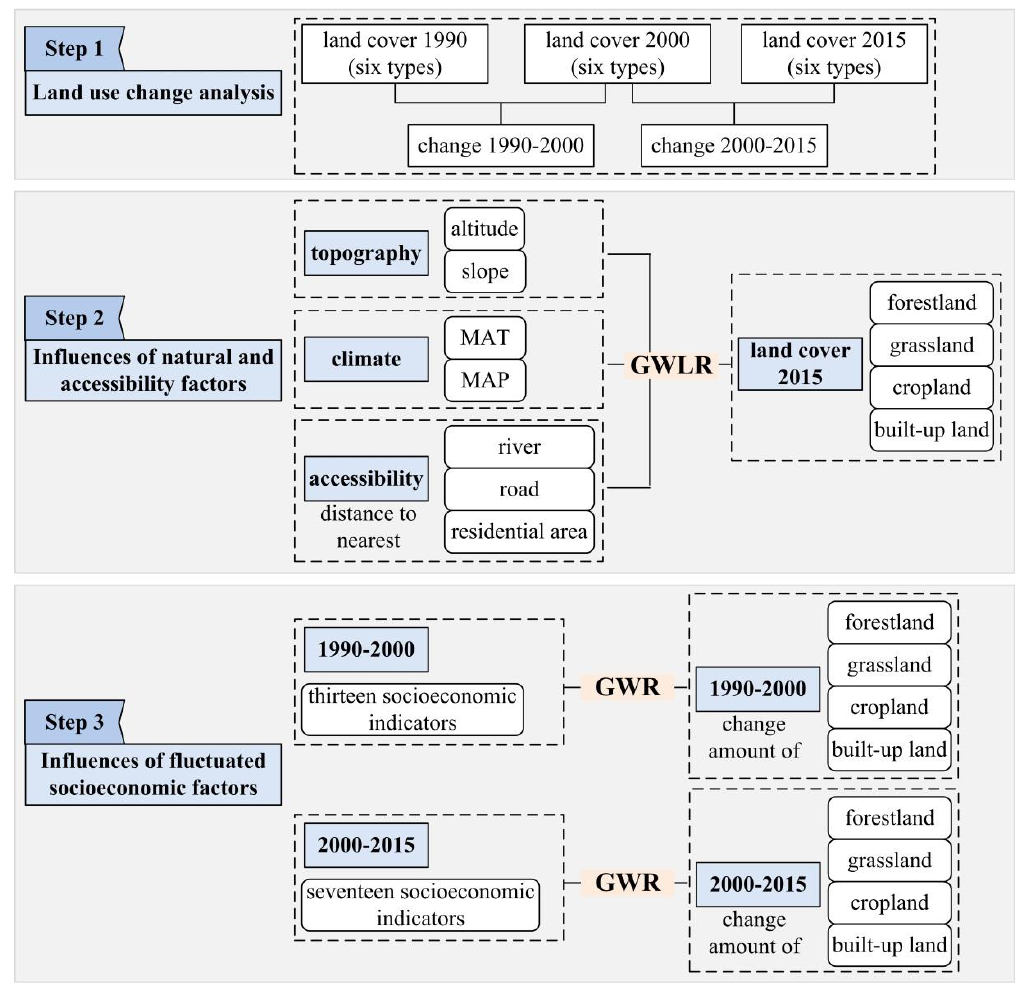
Figure 2. Study flowchart. MAT = mean annual temperature; MAP = mean annual precipitation.